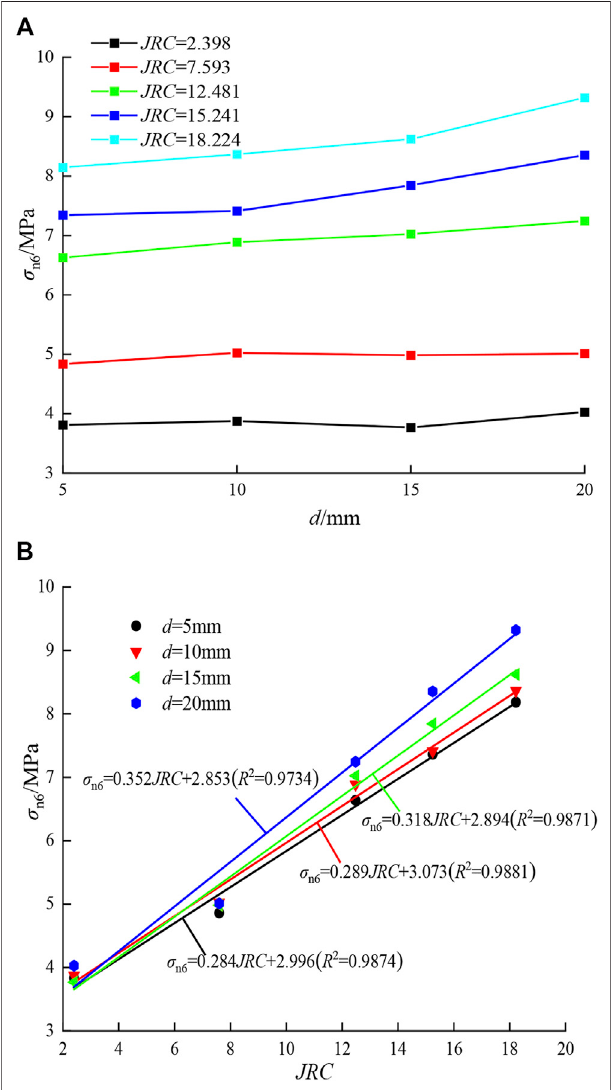
FIGURE 15 | Variation of σ n 6 with d and JRC. (A) d - σ n 6 . (B) JRC- σ n 6 .